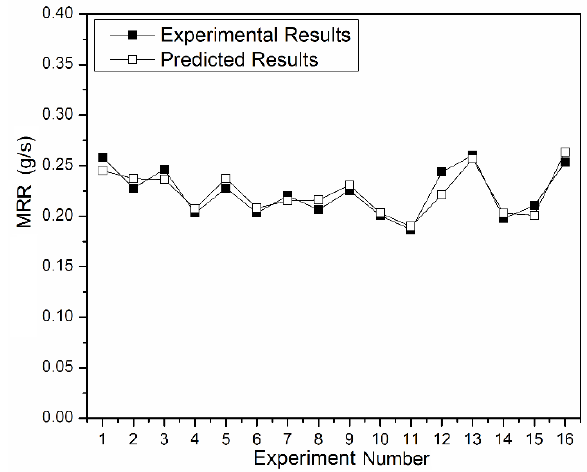
Figure 6. Comparison of the experimental and predicted results.